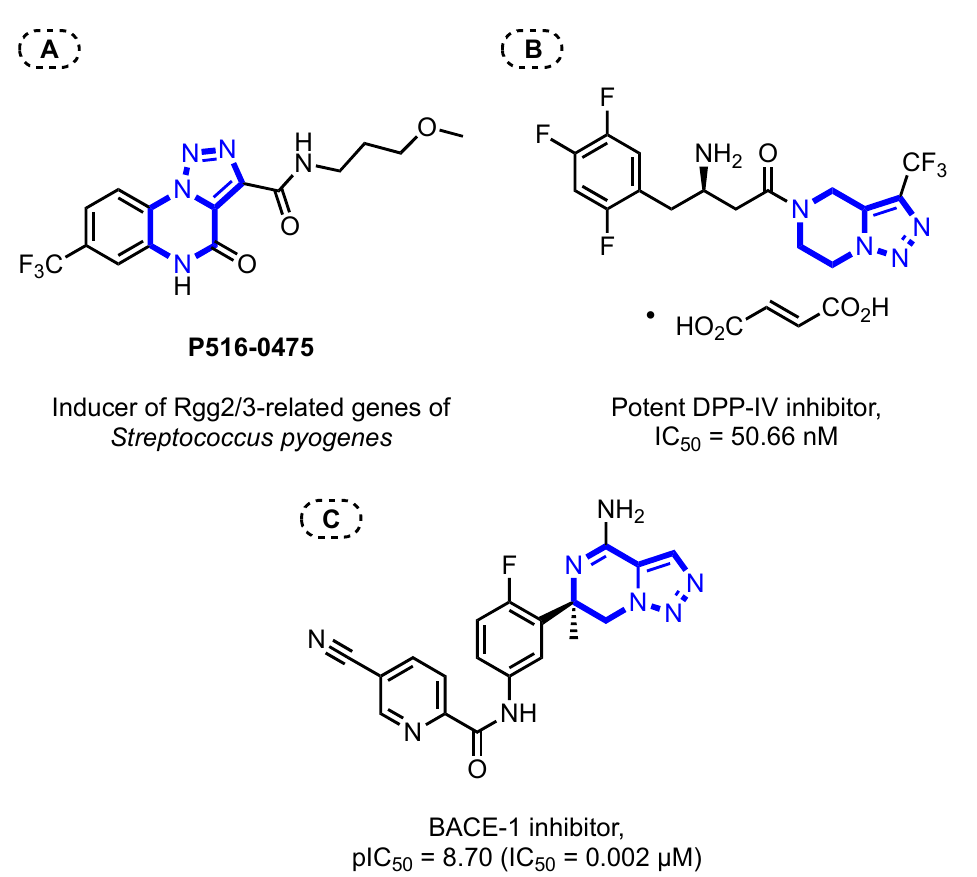
Figure 7. Compounds containing congeners of the 1,2,3-triazolo[1,5- a ]pyrazine core with a diverse set of biological activities: ( A ) an inducer of Rgg2/3-related genes of the human pathogen Streptococcus pyogenes [105] , ( B ) a potent DPP-IV inhibitor evaluated for the treatment of type II diabetes [7], and ( C ), an identified BACE-1 inhibitor [6].